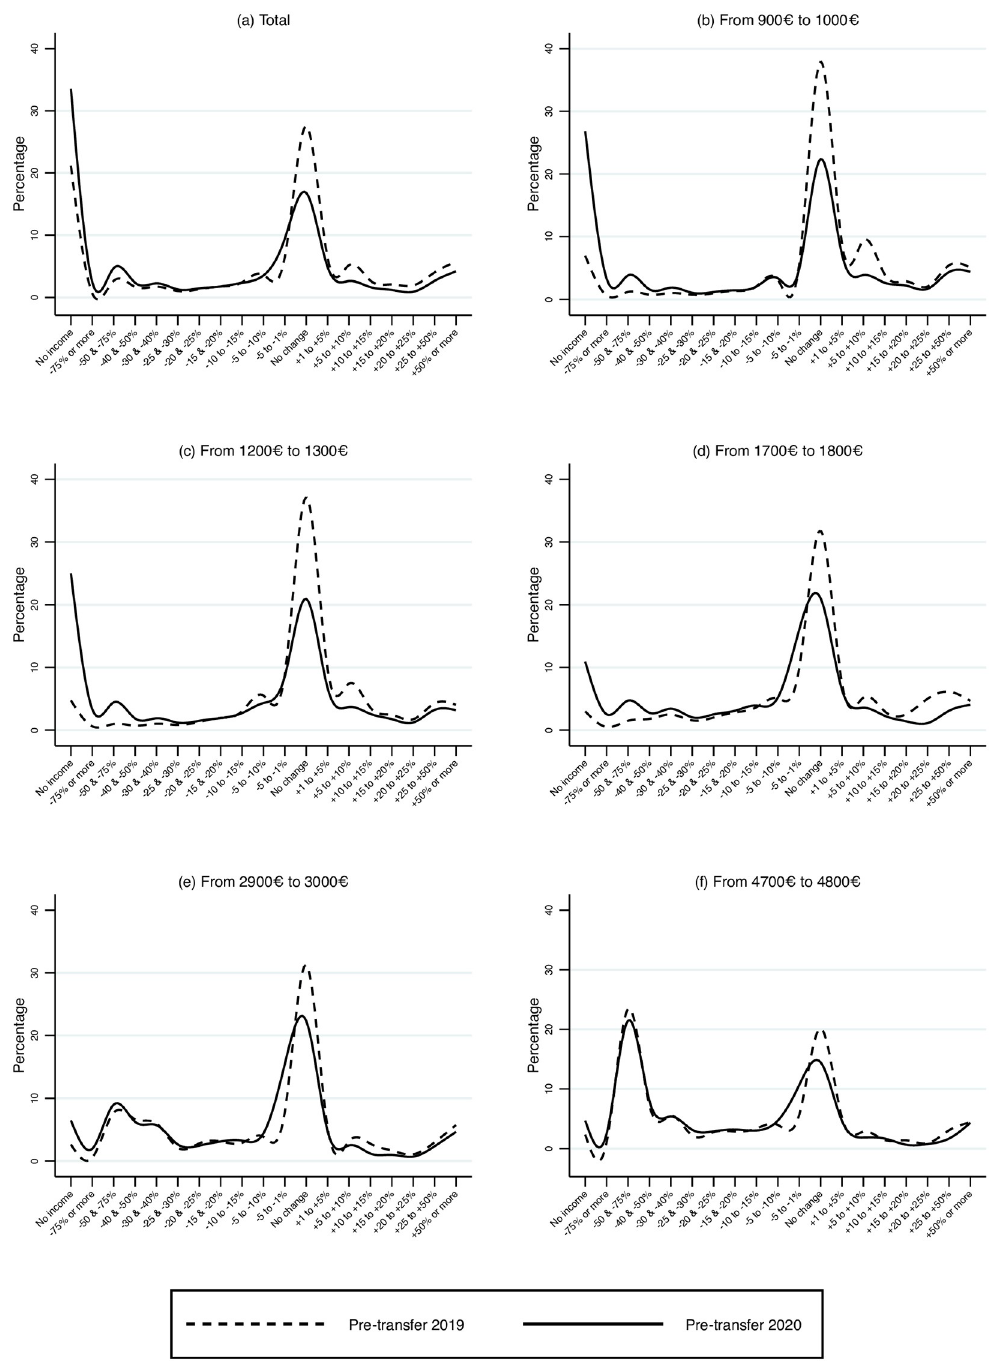
Fig 2. Changes in payments between April and February by level of wages in the reference period. Pre-benefits scenario. Comparing 2020 and 2019. for the entire sample; the other panels report the distribution for each of five wage brackets (measured as of February of 2020): i) the interval between 900 to 1,000 euros, which includes the 25th percentile of the wage distribution; the interval between 1,200 to 1,300 euros, which includes the median; the interval between 1,700 to 1,800 euros, which includes the 75th